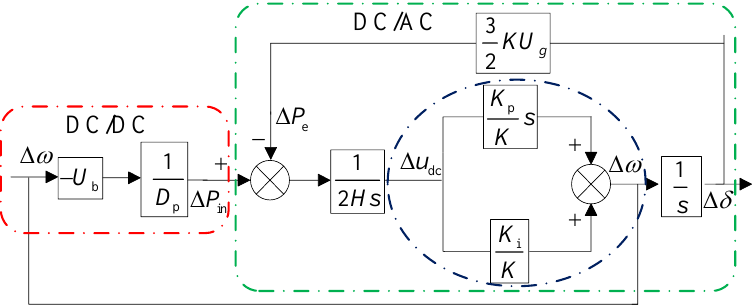
Figure 7. The Phillips – Heffron model of the DC distributed power system (DDPS).